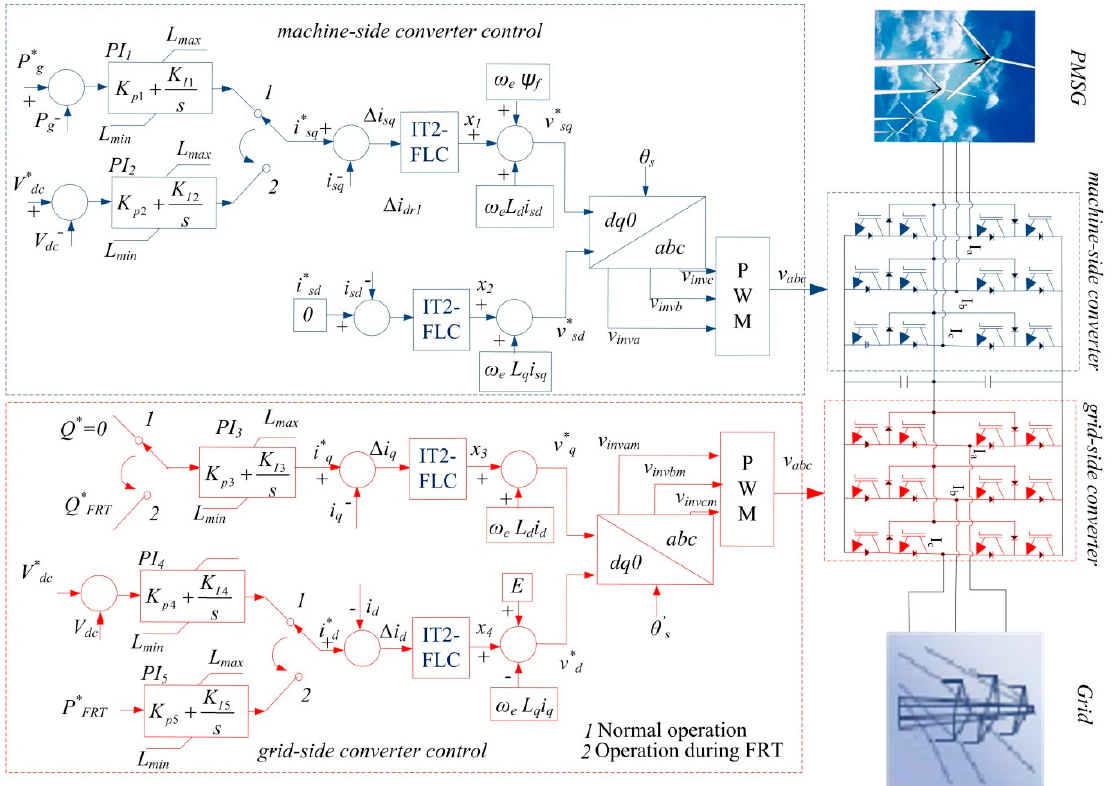
Figure 1. control structure of a permanent magnet synchronous generator (PMSG) based on a wind energy conversion system (WECS).